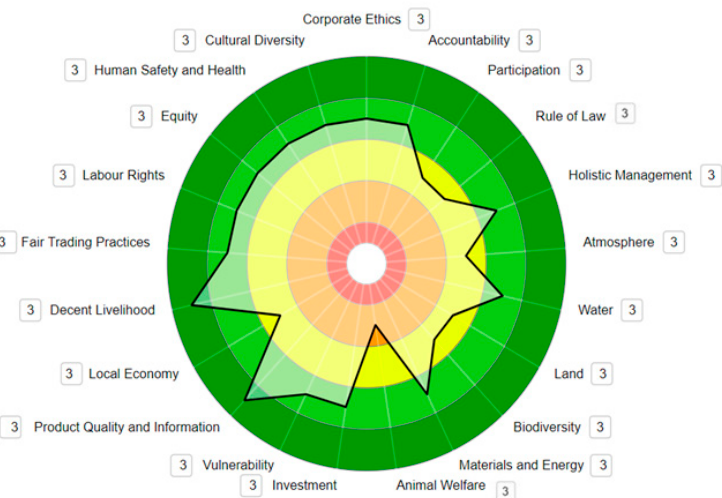
Figure 5. SAFA assessment result of the start ‐ up as spider graph. The number near indicators sug ‐ gest the data quality according to Table 4, and also, the colour in the circles represent the range score. As reported in Table 3, the colour means the performance score: Dark green: Best; light green: Good; yellow: Moderate; orange: Limited; red: Unacceptable. Low scores regarding soil indicators are due to the not ‐ cultivation of